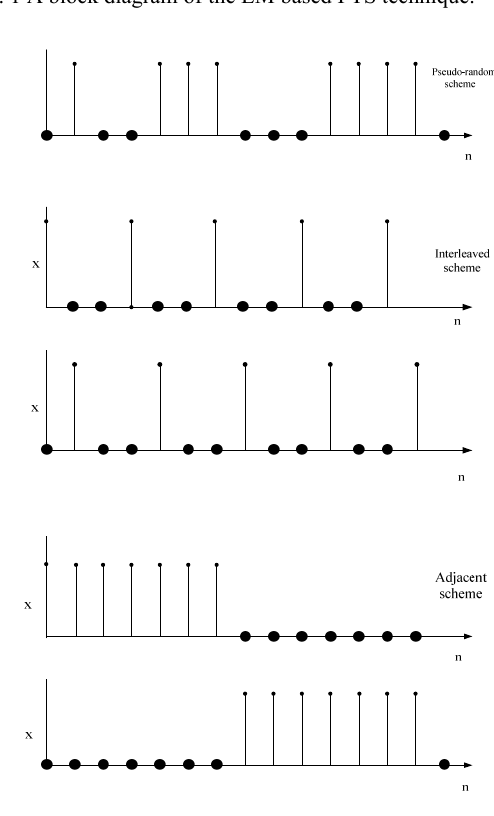
Fig. 2 Generation of sub-blocks partitioning